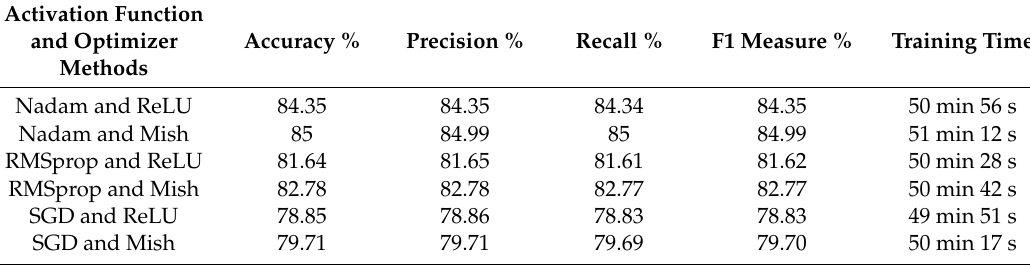
Table 7. The e ff ectiveness of VGG-16 with ReLU and Mish combined with other optimizers. Activation Function